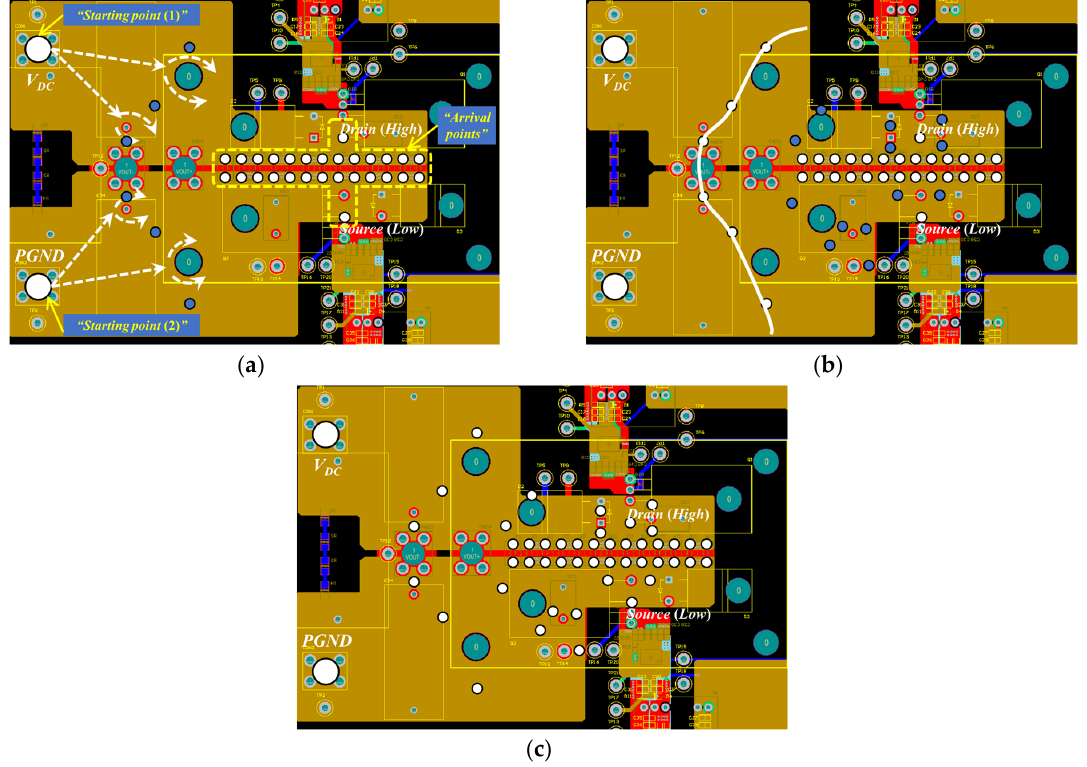
Figure 7. Lumped parameter modeling sequence (bottom layer of target PCB). ( a ) Region 1. ( b ) Region 2. ( c ) Selected result.